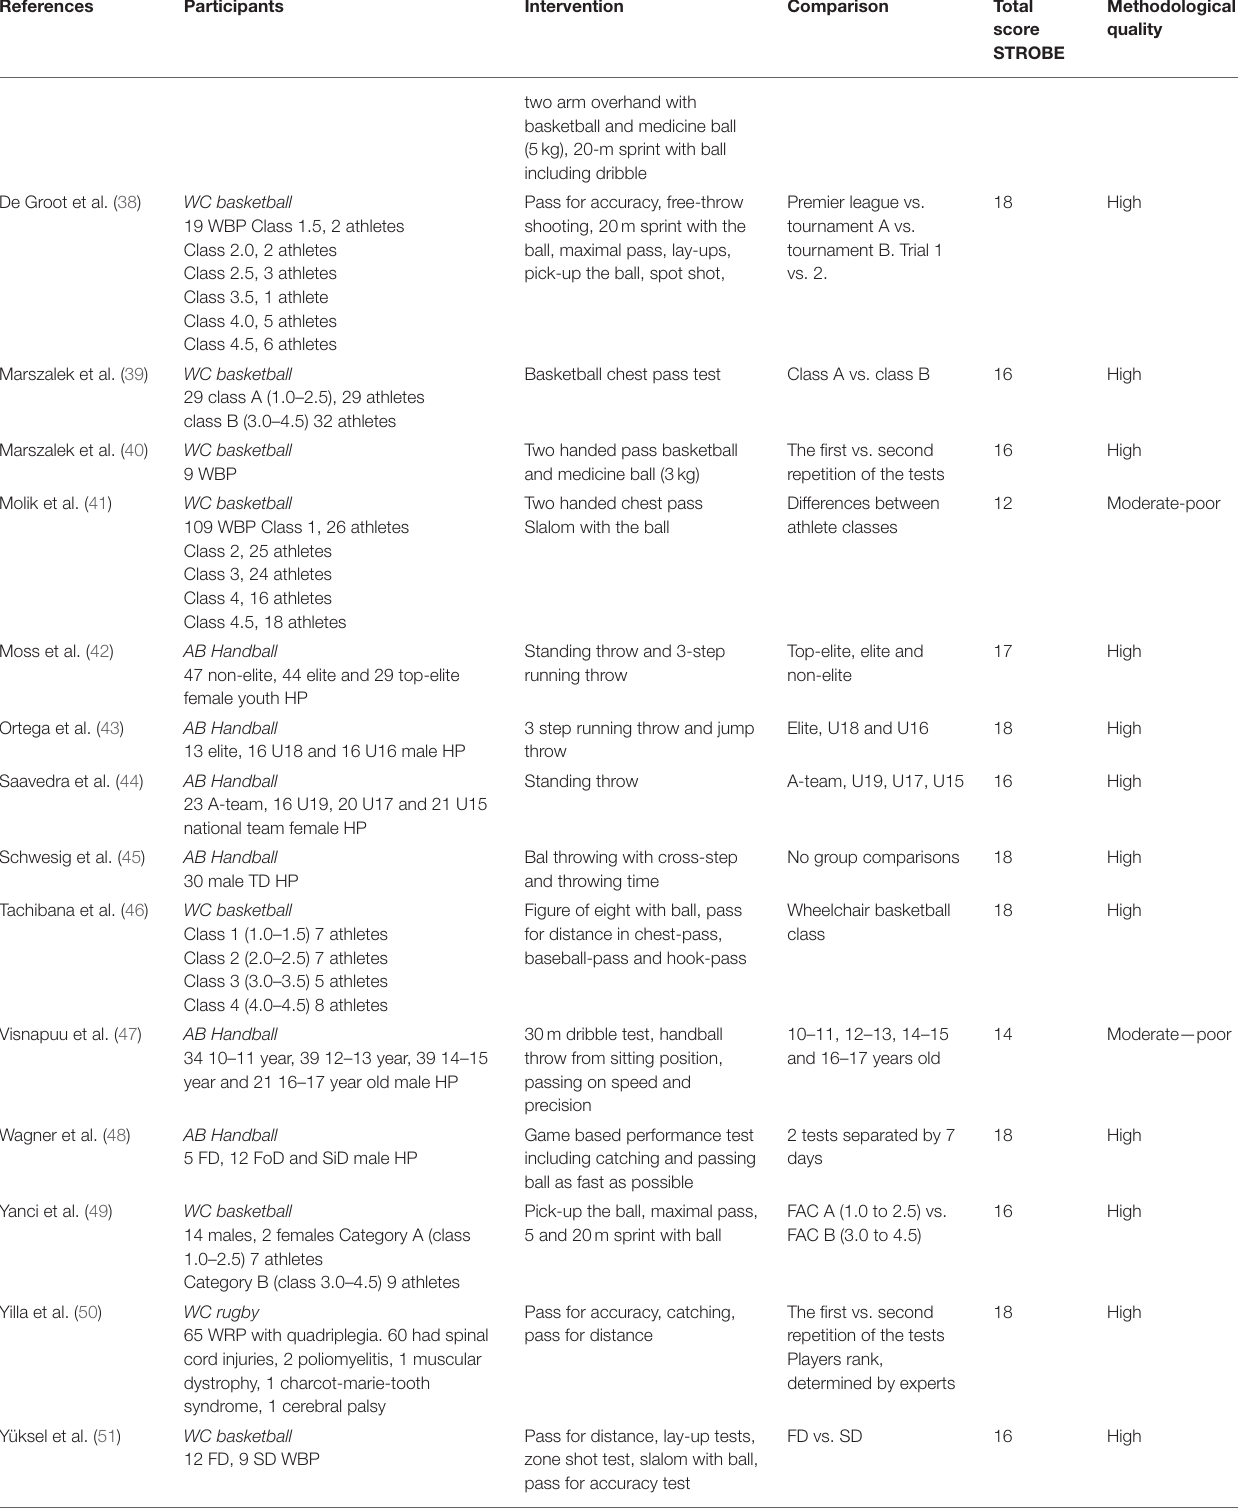
Figure of eight with ball, pass for distance in